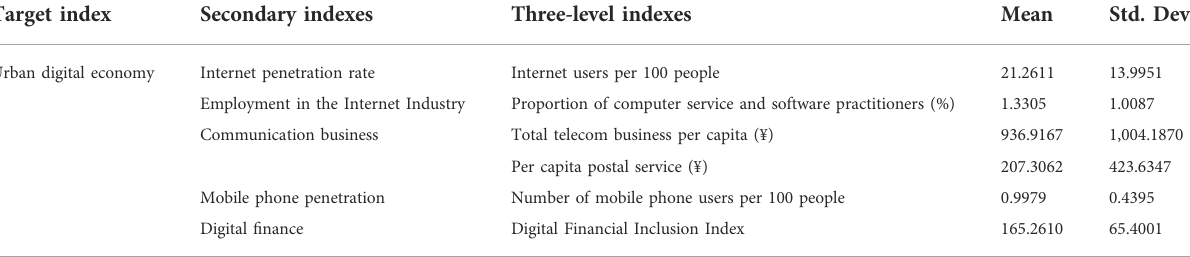
TABLE 1 Construction of digital economy indicator